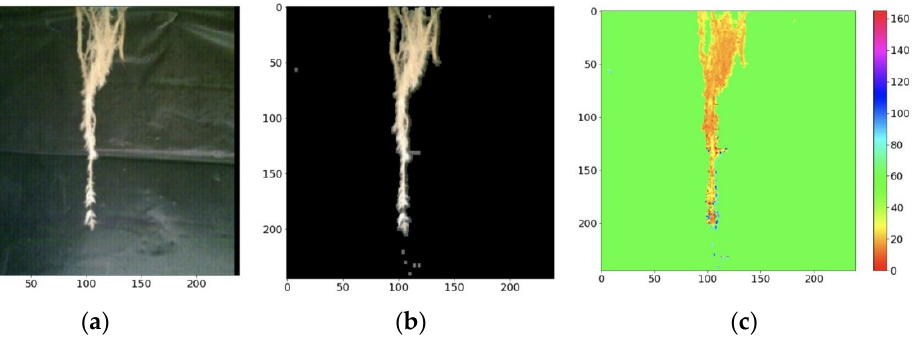
Figure 14. RGB and HSV images enhanced at root (day 1). ( a ) Original image of the root; ( b ) enhanced RGB image; ( c ) enhanced HSV image.